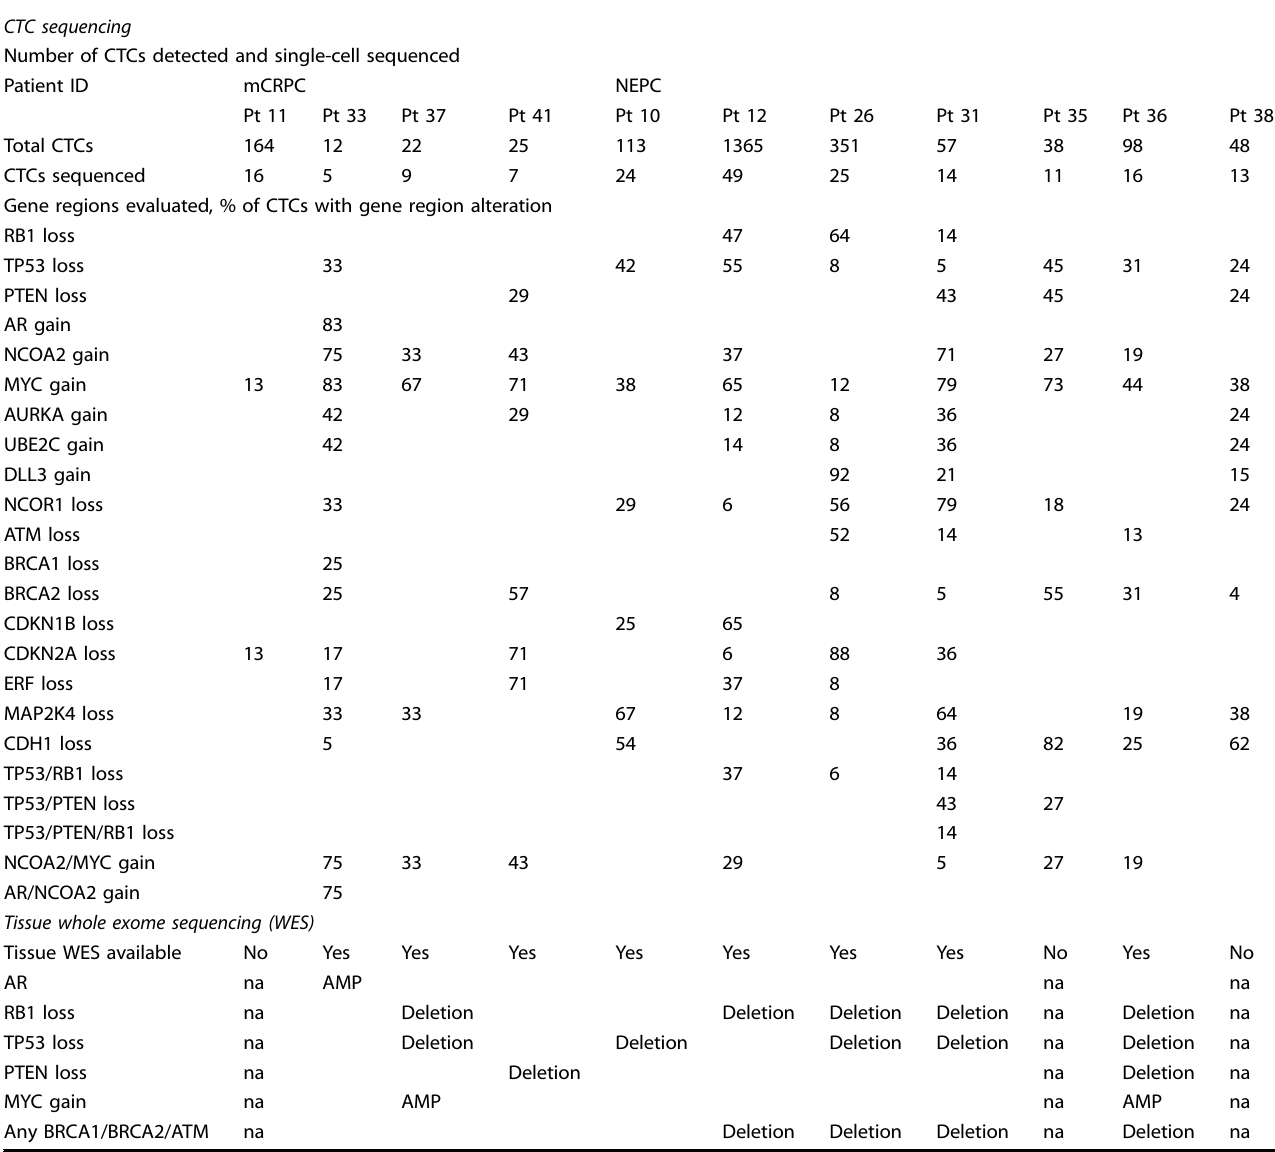
Table 2. Gene region alterations in single CTCs and comparison to tissue biopsy whole-exome sequencing (WES). CTC sequencing Number of CTCs detected and single-cell sequenced